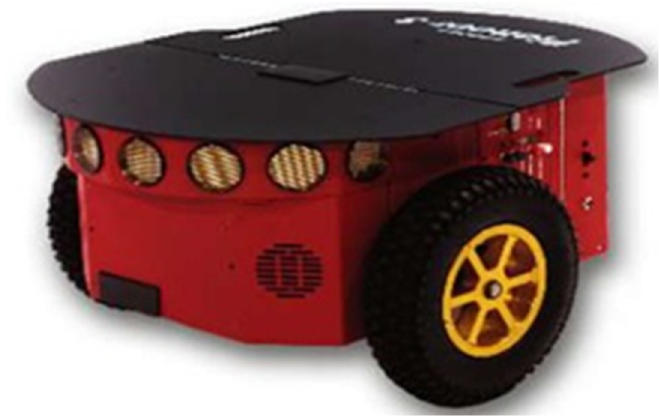
Figure 1. The Pioneer 3-DX mobile robot.